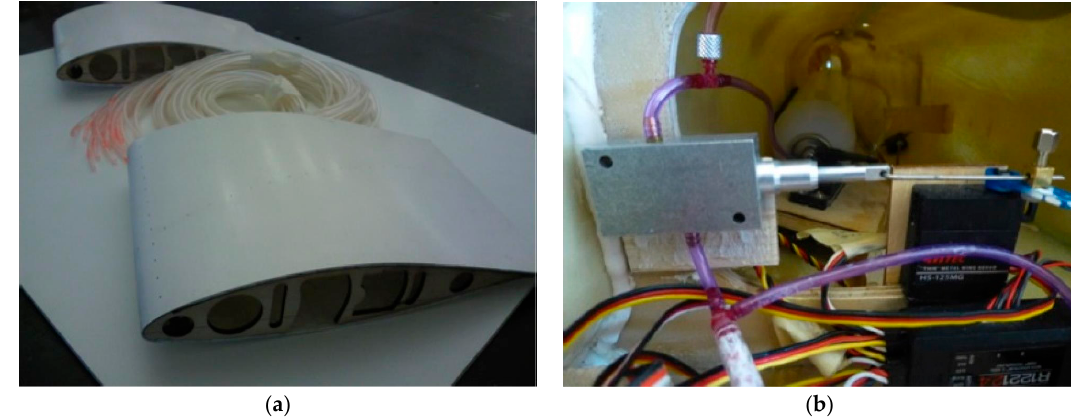
Figure 11. ( a ) Second instrumented wing glove and dummy. ( b ) Air tank and pressure regulator. (Reprinted from [38]).